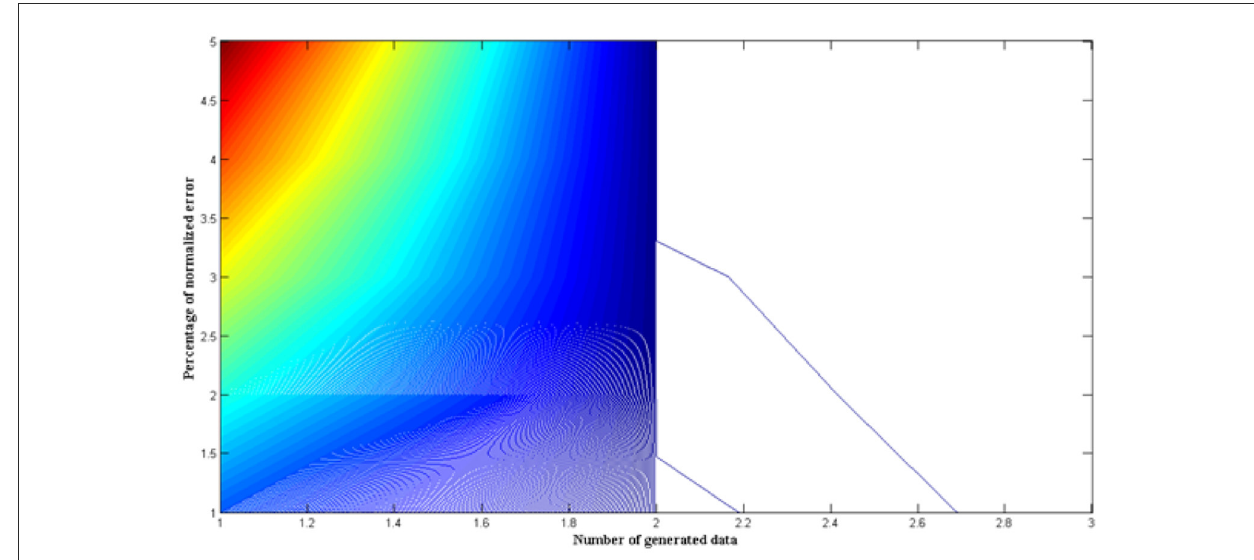
FIGURE6 Comparison of normalized errors.